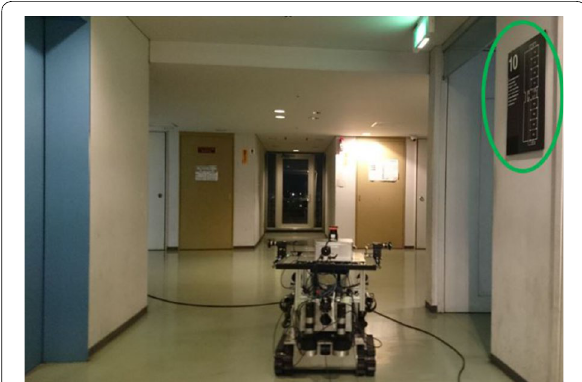
Fig. 1 Example of an indoor scene. The guide map is marked with a green circle on the upper right of the image. The guide map is beneficial for operators to decide directions for robots to reach their